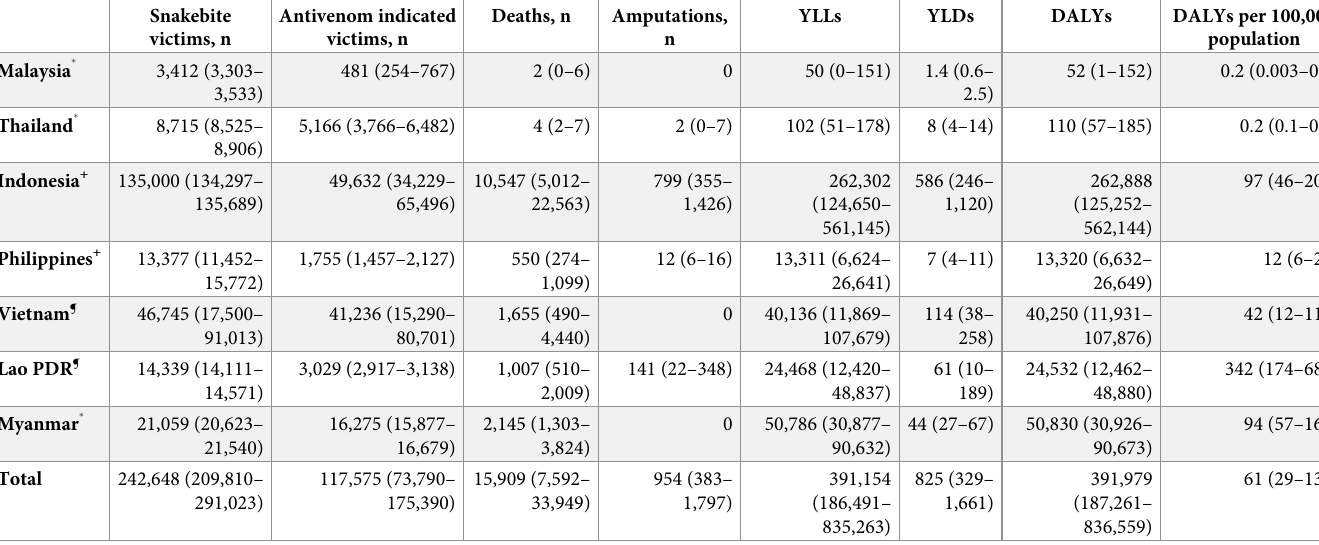
Table 1. Estimated annual disease burden of snakebite in ASEAN